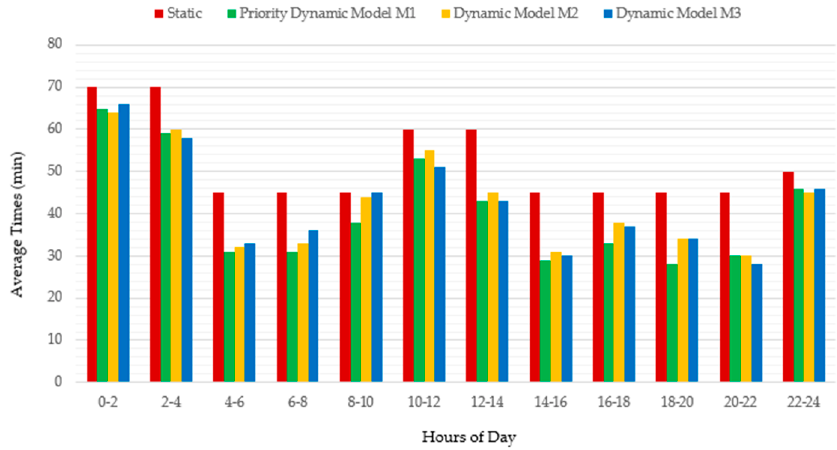
Figure 14. Spent time of the vehicles with control model M1 and comparison with another phase control models.